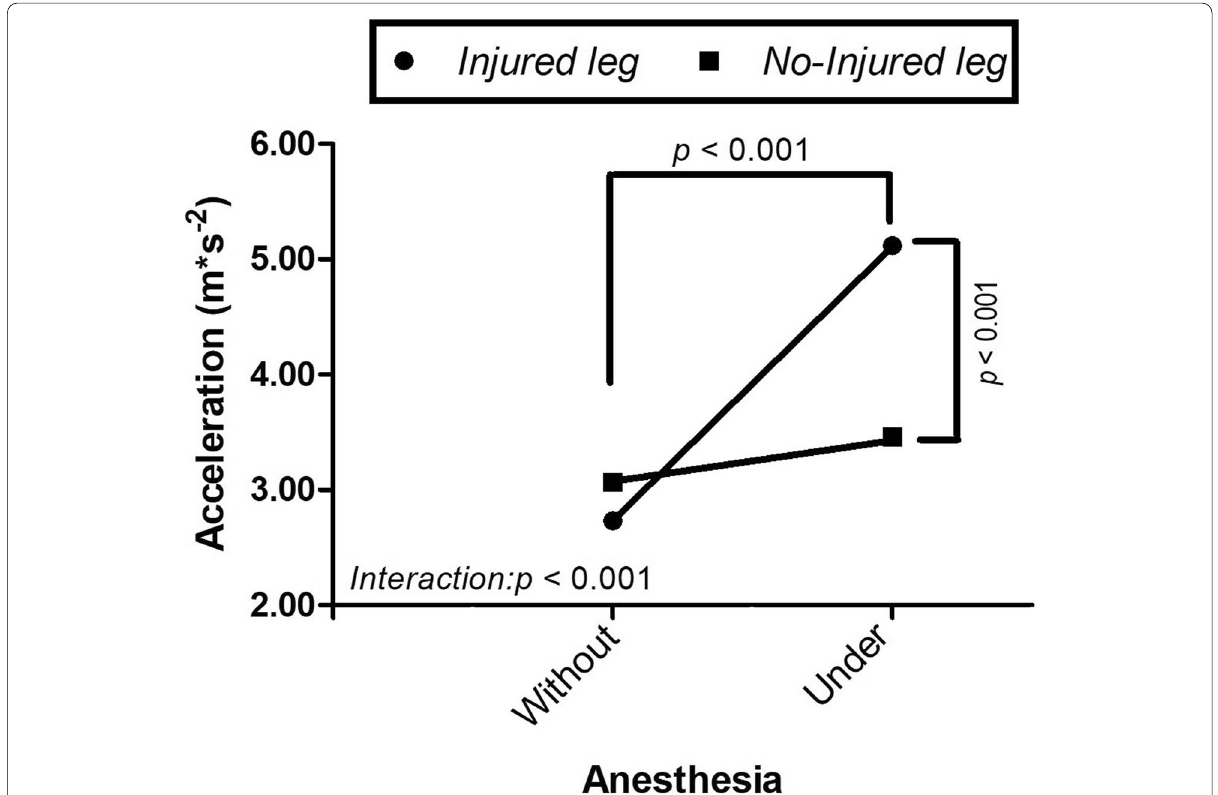
Fig. 3 Intra-operative pivot-shift assessment using an accelerometer in the lateral tibial plateau without and under anesthesia in patients with injured Anterior Cruciate Ligament